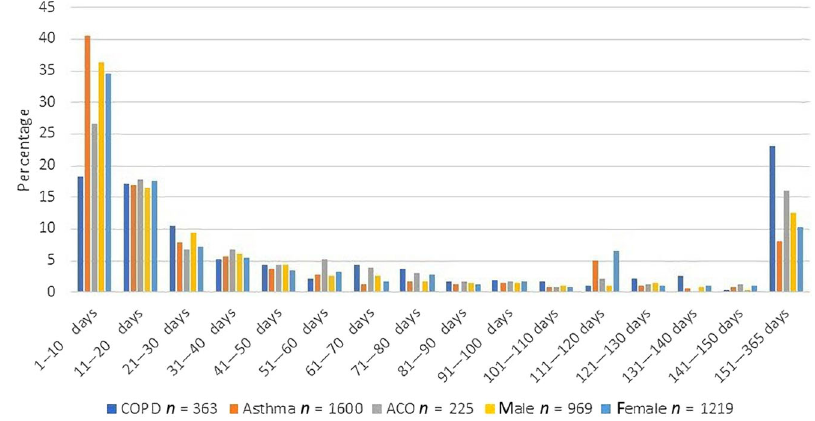
Fig. 2 Distributions of days absent (%) from work in Balearic respiratory patients with any work absence ( N = 2188).